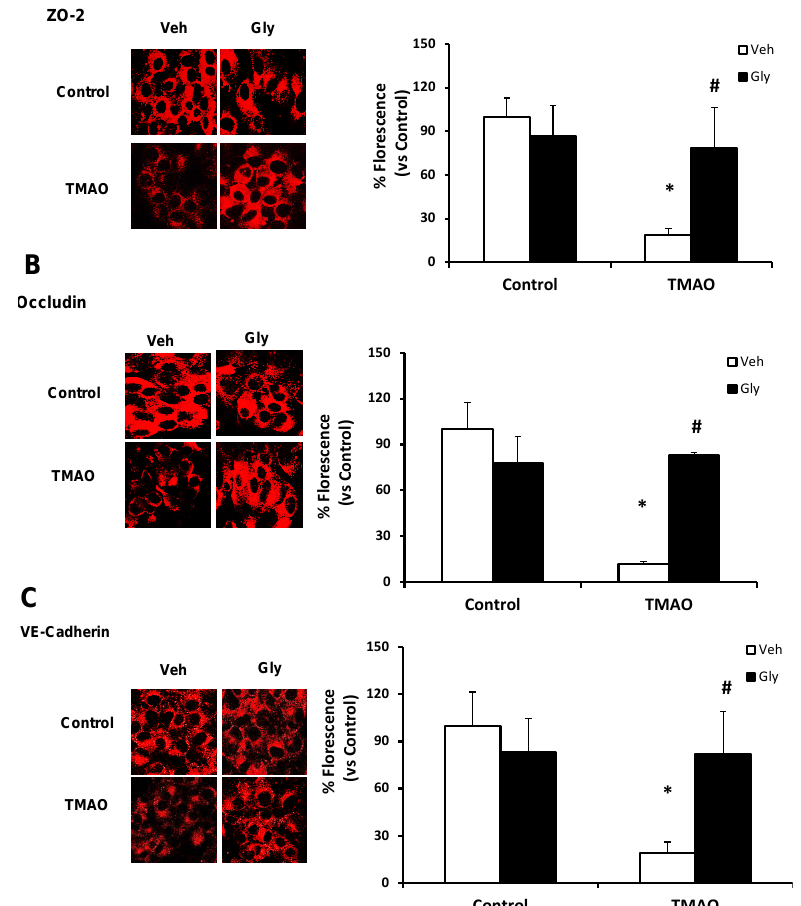
Figure 4. E ff ects of HMGB1 binder glycyrrhizin on TMAO-induced tight junction proteins ZO-2, Occludin, and VE-Cadherin in EOMAs. Representative confocal images ( n = 3–5) show the ZO-2 ( A ), Occludin ( B ), and VE-Cadherin ( C ) expression in EOMAs with or without stimulation of TMAO and / or HMGB1 inhibition by glycyrrhizin. Veh: vehicle. * significant di ff erence from control, # significant di ff erence from